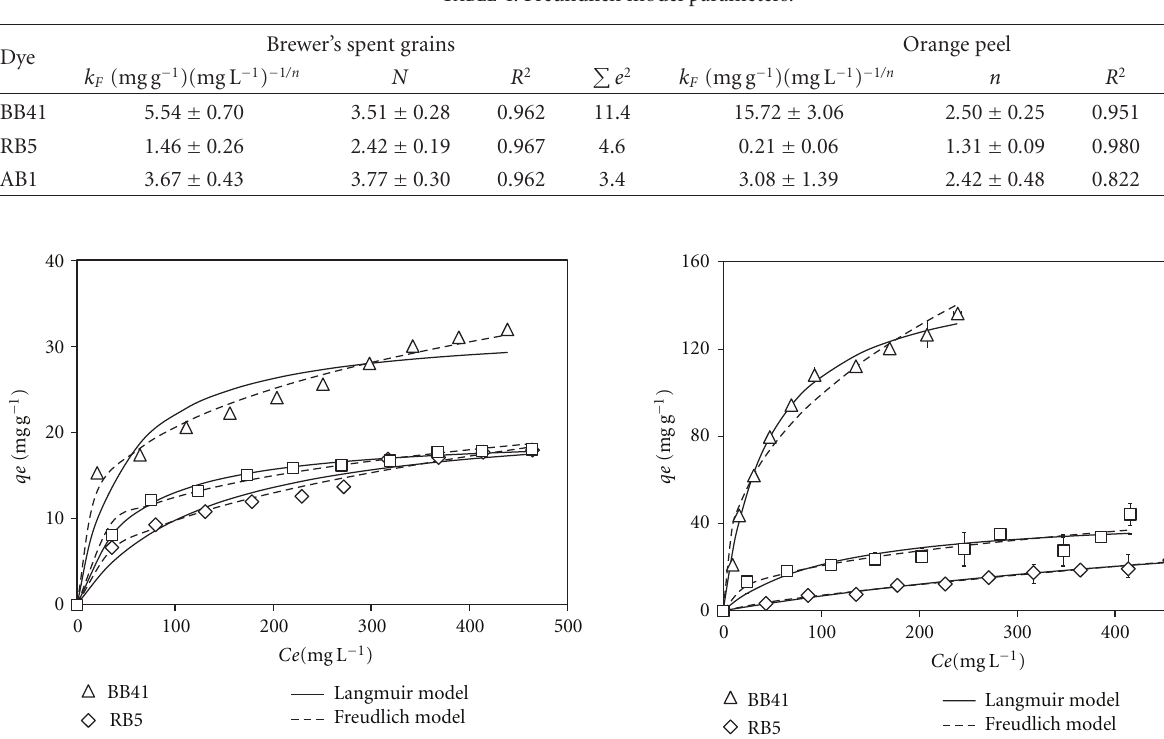
Table 4: Freundlich model parameters.